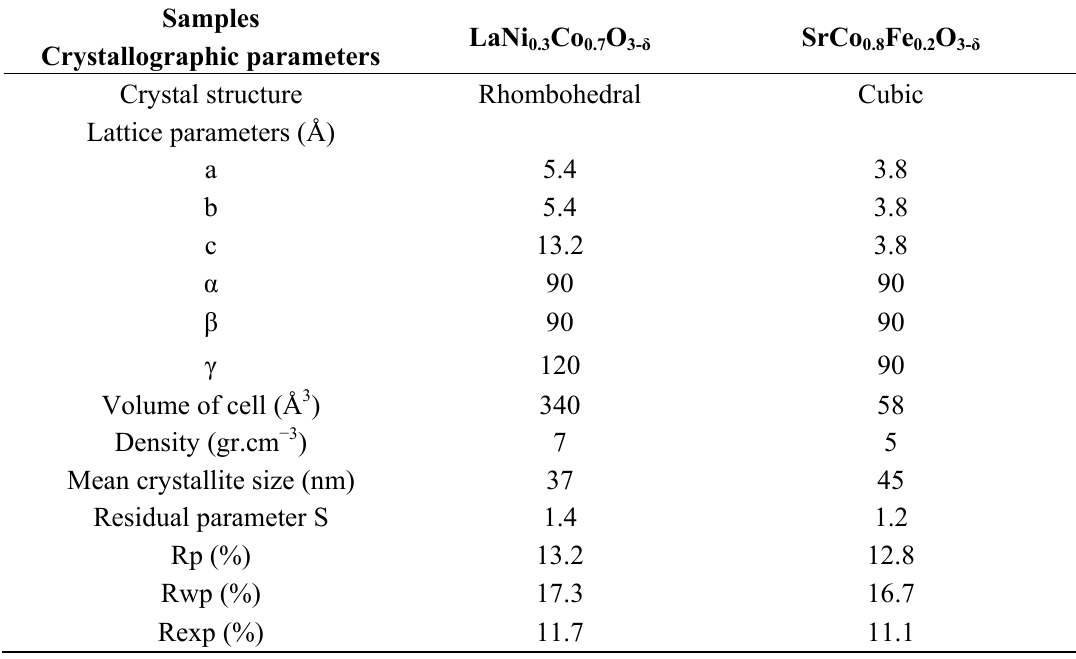
Table 1. Crystallographic parameters of the samples studied obtained from the diffractograms and from Rietveld